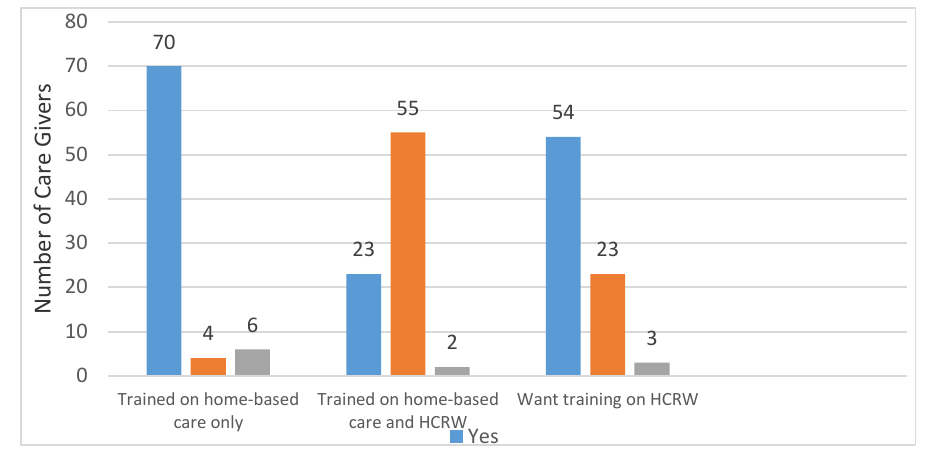
Figure 3. Training. Figure 3.